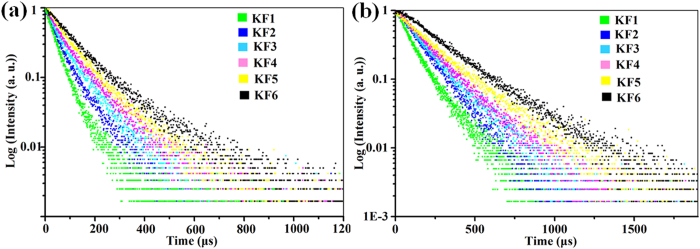
The decay curves for the 4S3/2 → 4I15/2(a) and 4F9/2 → 4I15/2 (b) emissions of Er3+ in β-NaYF4:20%Yb3+, 2%Er3+ samples prepared with different molar ratio of KF to RE3+.